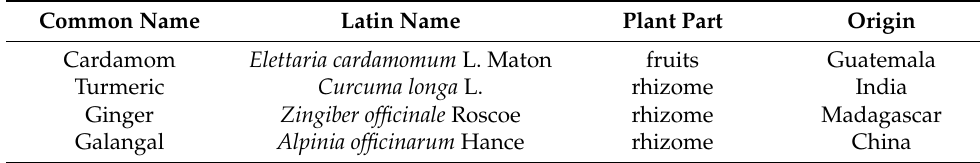
Table 2. Information of the analyzed plant material. Common